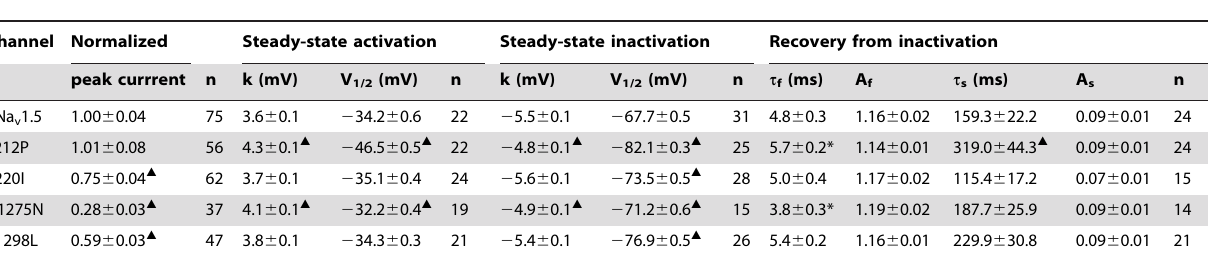
*indicates p , 0.05 versus hNa v 1.5. m indicates p , 0.01 versus hNa